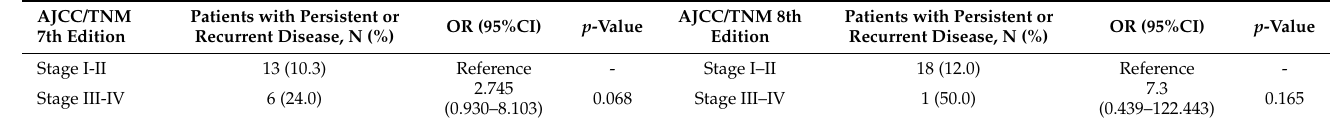
Table 5. Relative risk of persistence of relapse of disease at last follow-up as per AJCC/TNM